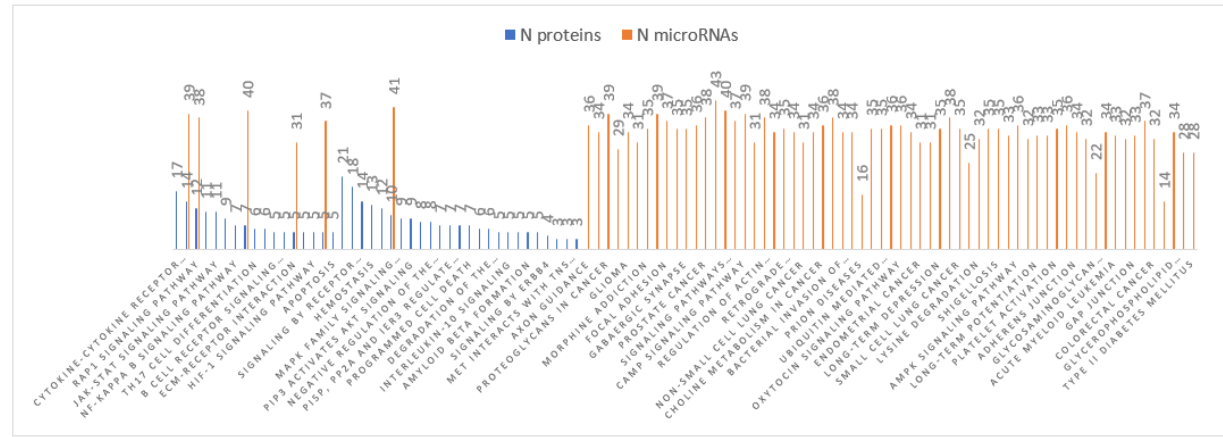
Figure 3. Braak stage III-IV pathways analyses.